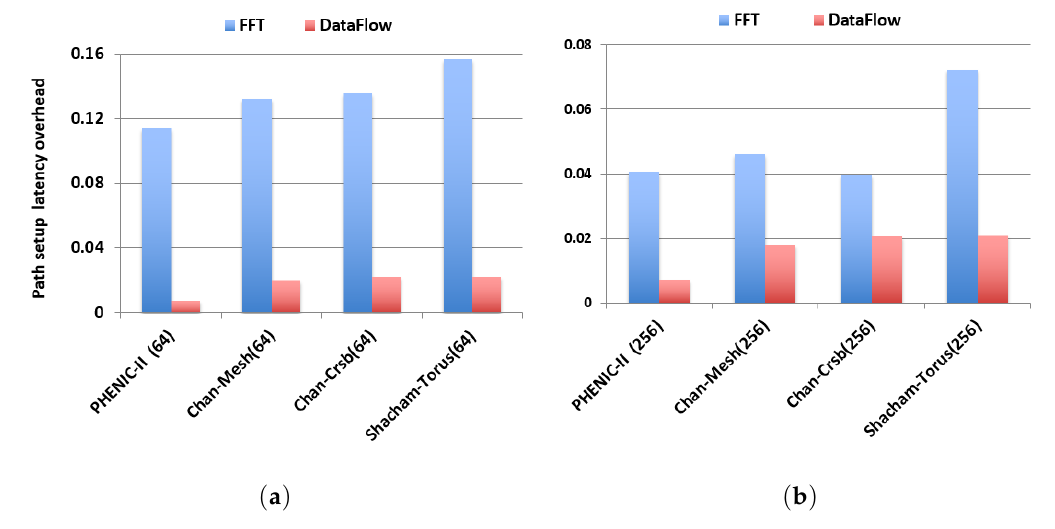
Figure 15. Average path setup latency overhead comparison results: ( a ) 64 cores; ( b ) 256